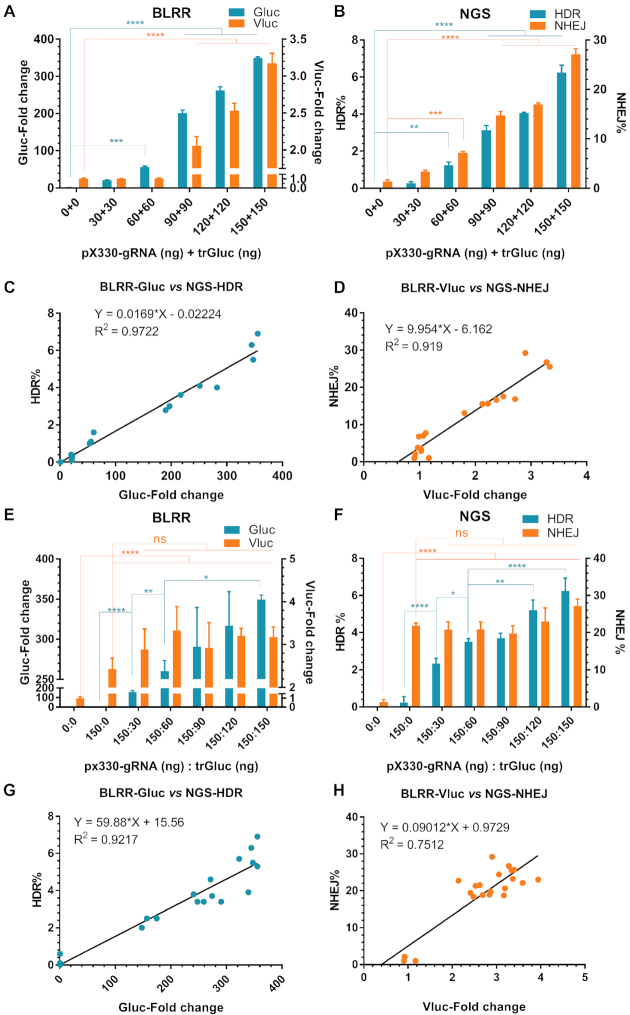
BLRR assay data are consistent with NGS results. (A) BLRR reporter activities increase with increasing HDR/NHEJ events. Both Gluc and Vluc signals increase as the amount of transfected pX330-gRNA and trGluc is increased. Gluc and Vluc signals exhibit significant differences at 60 + 60 ng and 90+90 ng compared with 0 + 0 ng controls. BLRR signals are normalised against cell viability and shown as the fold change relative to the 0 + 0 group (mean ± SEM of three biological replicates). Representative data from three independent experiments are shown. (B) NGS analysis of cells from (A) showing a consistent trend in HDR% and NHEJ% to those of the BLRR assay. NGS analysis of (A) showing that HDR and NHEJ events increase as the amount of transfected pX330-gRNA and trGluc is increased. Data are presented as mean ± SEM of three biological replicates. (C) BLRR assay Gluc values are strongly correlated (R2 = 0.9722) with NGS-detected HDR events. (D) BLRR assay Vluc values are strongly correlated (R2 = 0.919) with NGS-detected NHEJ events. (E) BLRR assay results showing that the Gluc signal is increased as the amount of transfected trGluc donor template is increased. The Vluc signal remains similar when different amounts of trGluc are applied and pX330-gRNA remains constant. BLRR signals are normalised against cell viability, and results are shown as the fold change relative to the 0+0 group (mean ± SEM of three biological replicates). Representative data for three independent experiments are shown. (F) NGS analysis of cells from (E) showing an increase in HDR events when the amount of trGluc is increased, as reported by the BLRR assay. NGS analysis of (E) showing an increase in HDR as the amount of trGluc is increased while NHEJ remains unaffected, corroborating the BLRR assay results. Data are presented as mean ± SEM of three biological replicates. (G) BLRR assay Gluc values are strongly correlated (R2 = 0.9217) with NGS results showing an increase in HDR events. (H) BLRR assay Vluc values and NGS-NHEJ (%) are strongly correlated (R2 = 0.7512). Significance was calculated using one-way ANOVA compared to 0+0 ng controls or as indicated followed by Tukey's post-hoc test (*P < 0.05, **P < 0.01, ***P < 0.001, ****P < 0.0001).